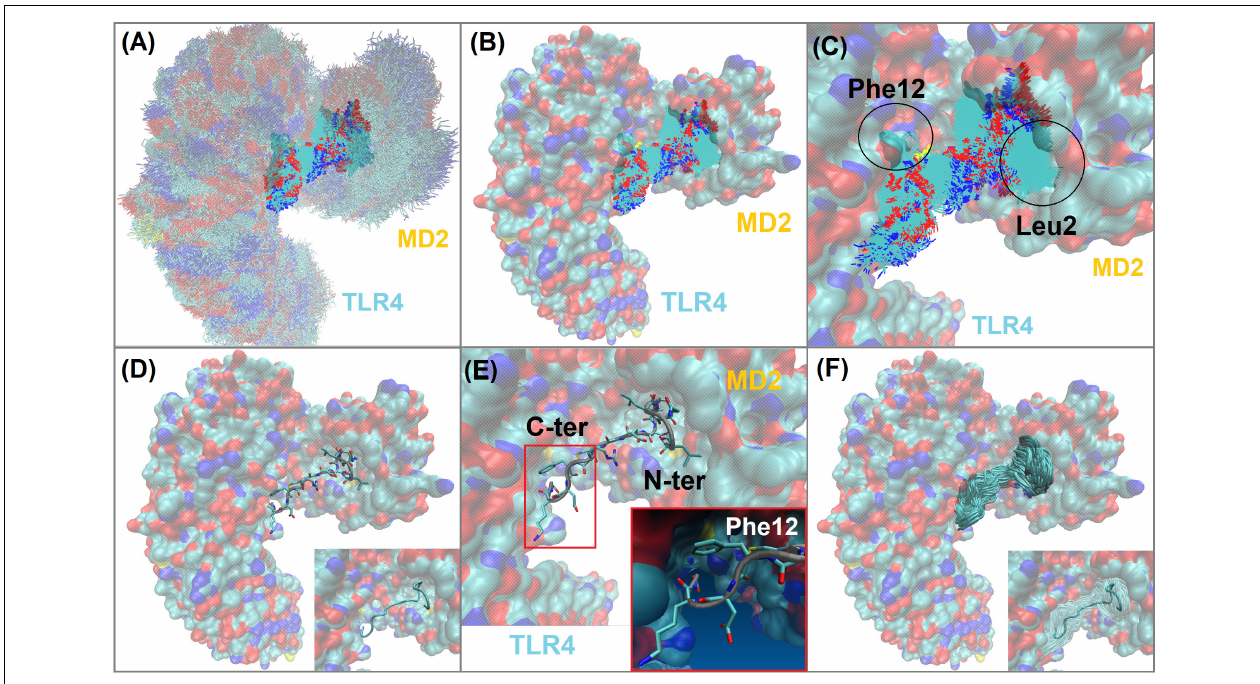
FIGURE 4 | TLR4/MD2/Peptide-2 complex simulated by molecular dynamics at 310 K for 100 ns. (A) Molecular dynamics (MD) trajectory superposition of TLR4/MD2/Peptide-2 MD. (B) Peptide-2 trajectory superposition on TLR4/MD2 complex (surfaced by atom color). (C) Close-up of panel (B) , denoting the trajectory of Leu2 and Phe12 residues of Peptide-2 interacting with hydrophobic sites of MD2 and TLR4, respectively. (D) Representation of Peptide-2 (stick) at TLR4/MD2 LPS binding site (tube representation below). (E) Close-up of panel (D) showing Peptide-2 orientation and the small hydrophobic cleft of TLR4 where Phe12 side chain takes place during simulation. (F) Peptide-2 trajectory superposition (tube) on TLR4/MD2 complex (surfaced by atom color). Resulting trajectories were aligned with VMD “Trajectory tool” and were tracked every 10 steps over a total of 10,000, giving a total of 1,000 superposed conformations. All molecules are displayed without hydrogen atoms. All images were taken at 60 ns.